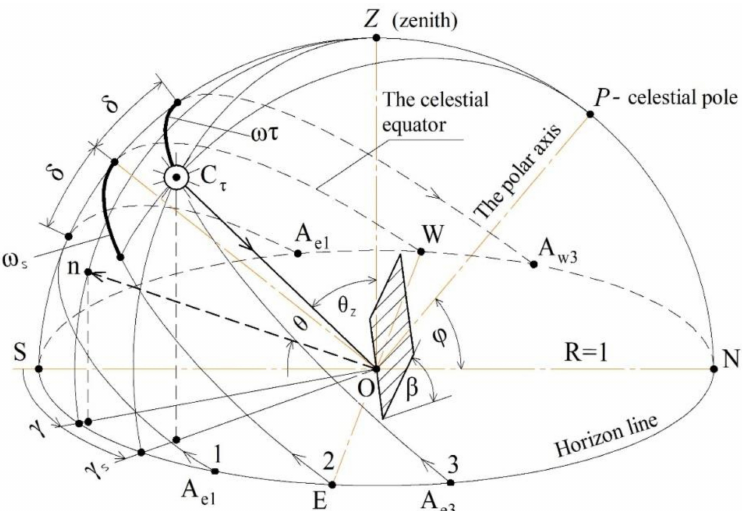
Figure 3. Scheme for determination of space-time parameters of the Sun and tracking surfaces; designed based on [21,23,35,36]: zenith, equinoctial line, polar axis, celestial pole, skyline. The angle space-time parameters of the Sun and of the tracking area are determined in two systems of coordinates, i.e., equatorial, directed along the polar axis OP and horizontal, along the zenith direction OZ . Radius of the conventional globe R is considered as equal to one. Seasonal trajectories of the Sun in the sky are presented for the period of summer and winter solstice and spring equinox. The Sun stays on the surface of a conventional globe and apparently rotates around the polar axis OP, inclined to the surface of horizon at the angle, which is equal to geographical latitude of the area ϕ . Its day trajectories are marked by three semi-cycles with the centers on the polar axis and correspond to: 1—winter season δ = +23.45 ◦ ; 2—equinox δ = 0; and 3—summer season δ = − 23.45 ◦ . The path of equinox coincides with the equinoctial line. Coordinates of the Sun are determined in the equatorial hour angle ω s = ω τ , measured from the southern direction; ω = 15 grad/h is an angle speed angle is measured along the equinoctial line: on the scheme it is marked by a heavy arc to the cross point with the equatorial vertical, i.e., the arc of a large circle, marked pole of the world, P